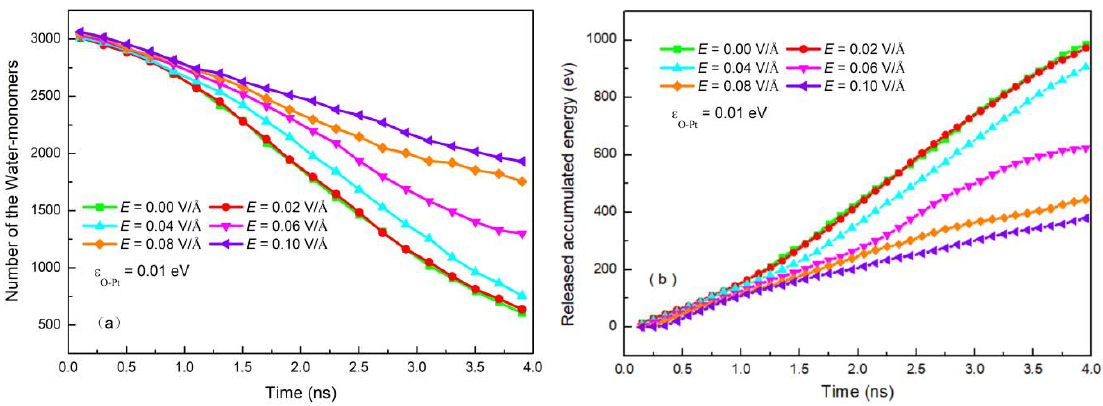
Figure 5. ( a ) The change of the number of monomers and ( b ) the released accumulated energy in the system with time under electric field.